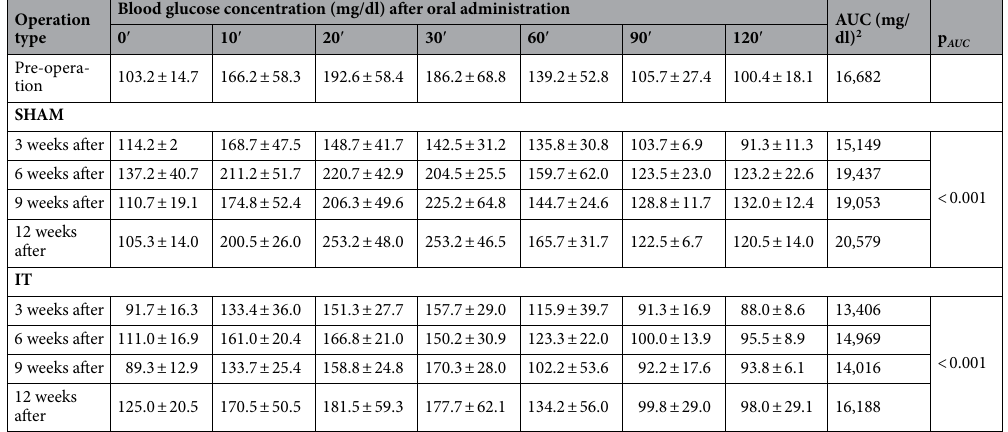
Table 3. Glucose concentration (mg/dl) measured in blood of Zucker (Crl:ZUC(ORL)-Lepr fa ) rats at consecutive time points during oral glucose tolerance test (OGTT) performed before and 3, 6, 9, 12 weeks after ileal transposition (IT) or control (SHAM) surgery. The results are presented as mean ± standard deviation. AUC area under curve.